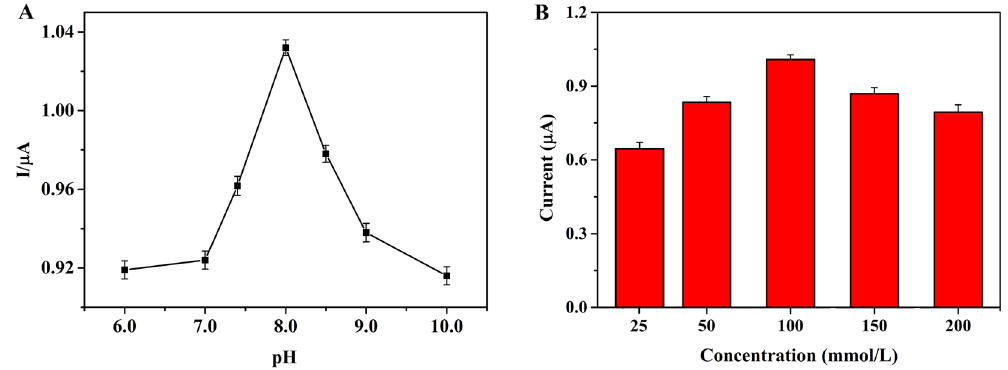
Figure 3. Optimizations of experimental parameters: ( A ) pH value, ( B ) Concentration of PBS. Error bars are standard deviations.